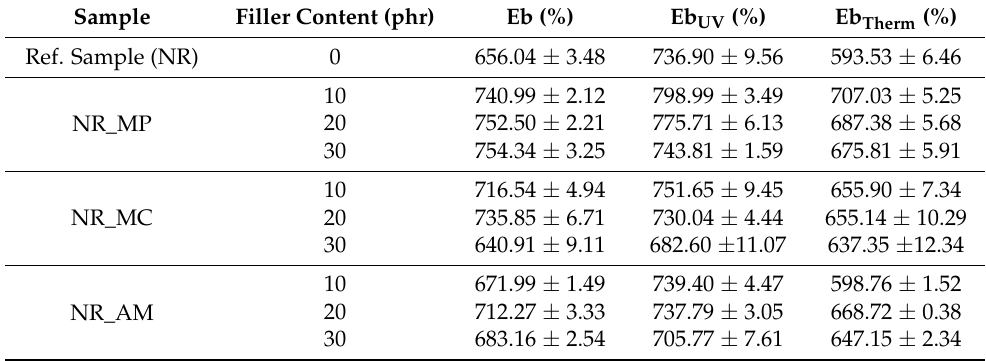
Figure 12. Results of tensile strength measurements of unaged samples (TS), after ultraviolet (UV) and thermo-oxidative (Therm) aging. Table 5. Elongation at brake before (Eb) and after ultraviolet (Eb UV ) and thermo-oxidative (Eb Therm )